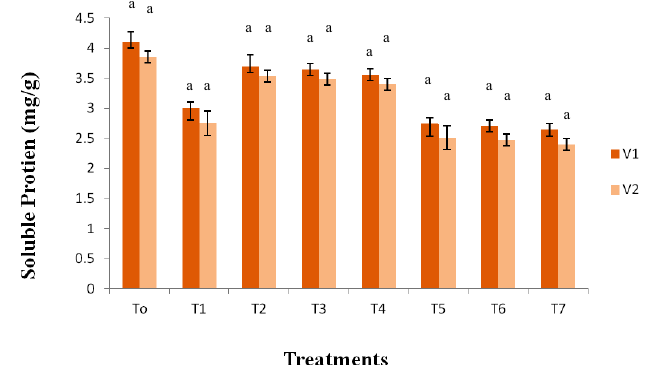
Fig. 3A: Effect of Azospirillum inoculation on proline content of two canola varieties (v1 and v2) grown under drought stress. Where, To = Un-inoculated and well watered, T = Un-inoculated and drought exposed, T2 = Seed inoculated and well watered, T3 = Rhizosphere inoculated and well watered, T4 = Seed inoculated with heat killed inoculums and well watered, T5 = Seed inoculated and drought exposed, T6 = Rhizosphere inoculated and drought ex- posed, T7 = Seed inoculated with heat killed inoculums and drought exposed. And V1 = Rainbow, V2 = Con II.